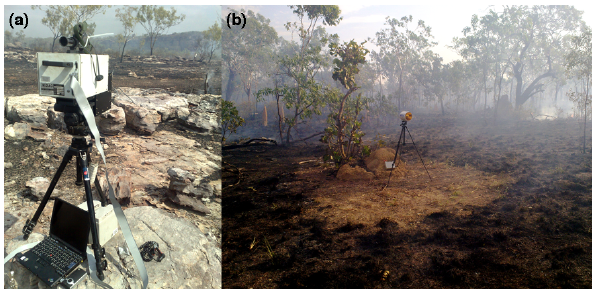
Figure 1. Photographs showing the use of natural and artificial fire- breaks to protect the OP-FTIR equipment during fires in which the open path between the spectrometer and IR source lay within the fire plots. (a) The FTIR spectrometer positioned on a rocky out- crop, with the fire being allowed to pass around the rocks; (b) The IR lamp protected by raked vegetation, notice the distinction be- tween the burnt and unburned